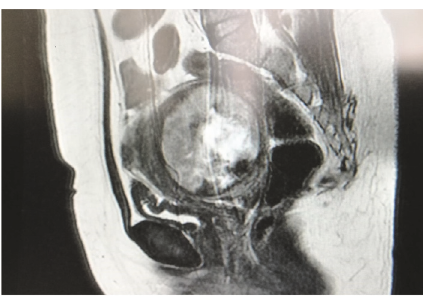
Figure 2: MRI image of myoma before surgery.